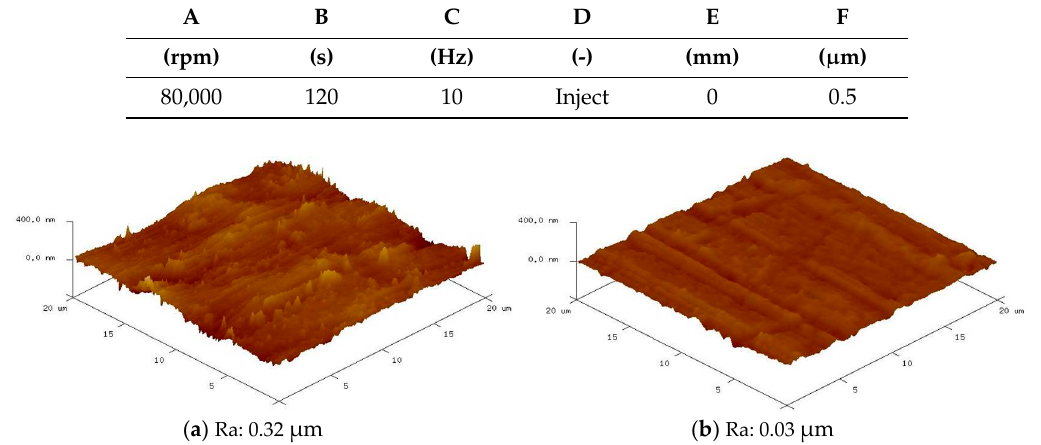
Figure 7. AFM images of the surface conditions ( a ) prior to and ( b ) after machining. micro-diameter is analyzed. Based on this analysis, a set of optimum process parameters were selected and an experiment was performed using this data. The optimum result obtained with the experiment is shown in Table 6. In order to ensure the correctness of the regression formula, three workpieces were selected and conducted with the same experiment, each work was tested six times from 0 to 120 s 18 times. The processing data was analyzed again by regression analysis to derive a and the processing time can be budgeted according to the desired accuracy.